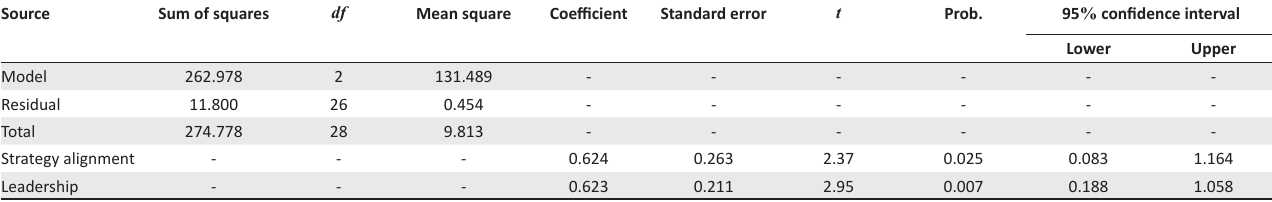
TABLE 1 : Strategy alignment and organisational performance. Source Sum of squares